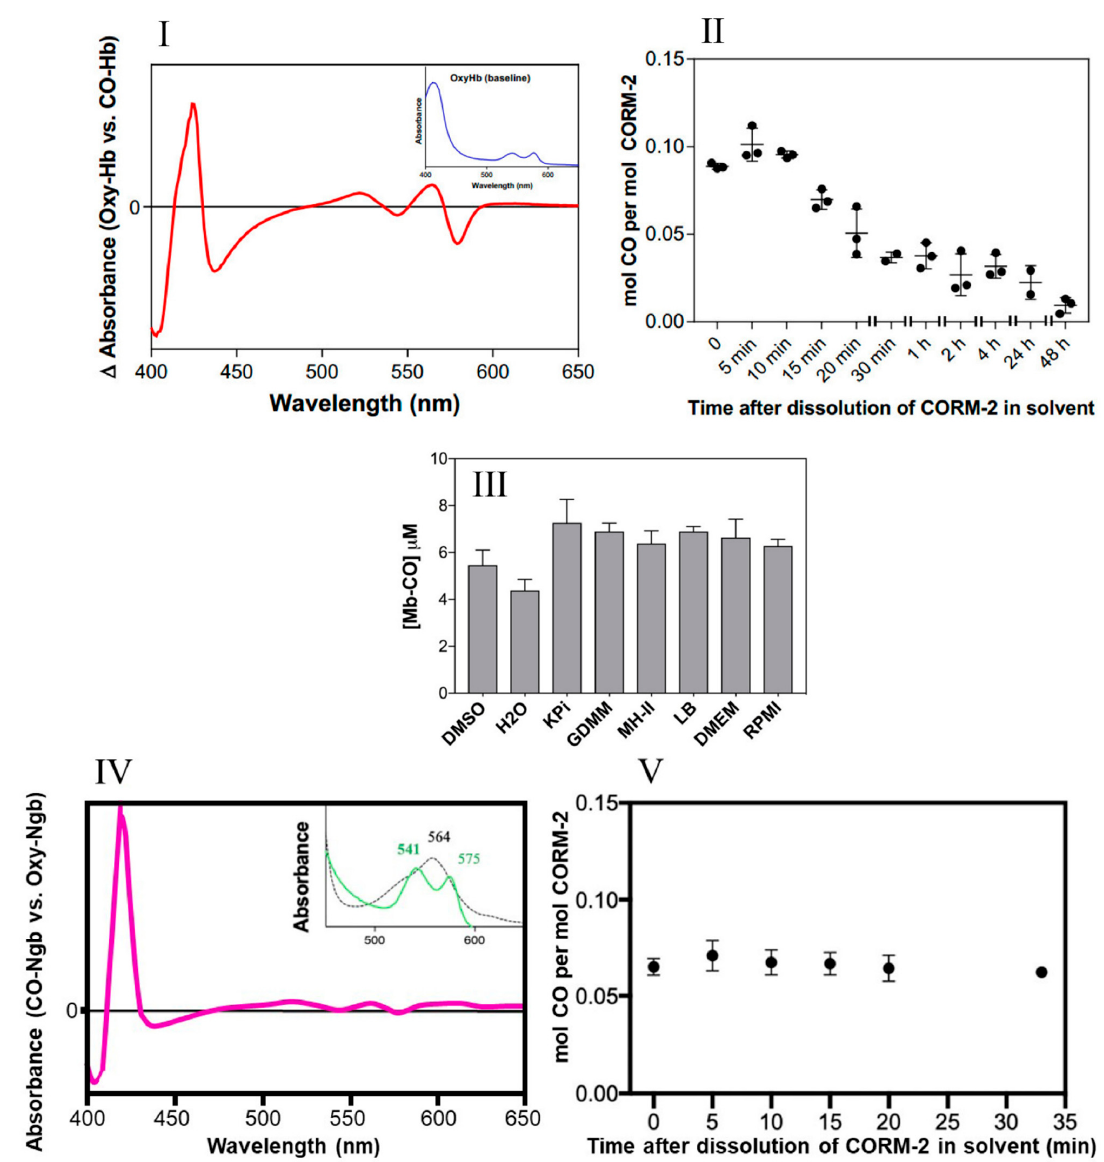
Figure 2. Little CO is released from CORM-2 in DMSO . ( I ) CO-difference UV-visible spectrum of CO-saturated haemoglobin with the absolute spectrum of the oxyHb sample (shown in inset) as a baseline. ( II ) Amount of CO detected as COHb expressed as a function of the age of the CORM-2 stock solution, i.e., time after dissolution of CORM-2 in DMSO (solvent). ( III ) Maximum yields of Mb-CO from 10 µ M CORM-2 as an average of two technical repeats, with SD shown as error bars. CO was detected after prior incubation for 20 min in a 10-fold excess of DMSO, water, KPi, GDMM, MH-II, LB, DMEM or RPMI. ( IV ) CO-difference UV-visible spectrum of neuroglobin with saturating CORM-2. The inset shows the absolute spectra of the reduced (dotted) and CO-bound forms (green). ( V ) Amount of CO detected as CO-Ngb expressed as a function of the age of the CORM-2 stock solution, i.e., time after dissolution of CORM-2 in DMSO. Data in II and V display individual data points from 3 independent replicates. Minimal autoxidation of the oxyglobins was established prior to each time point in II and V .